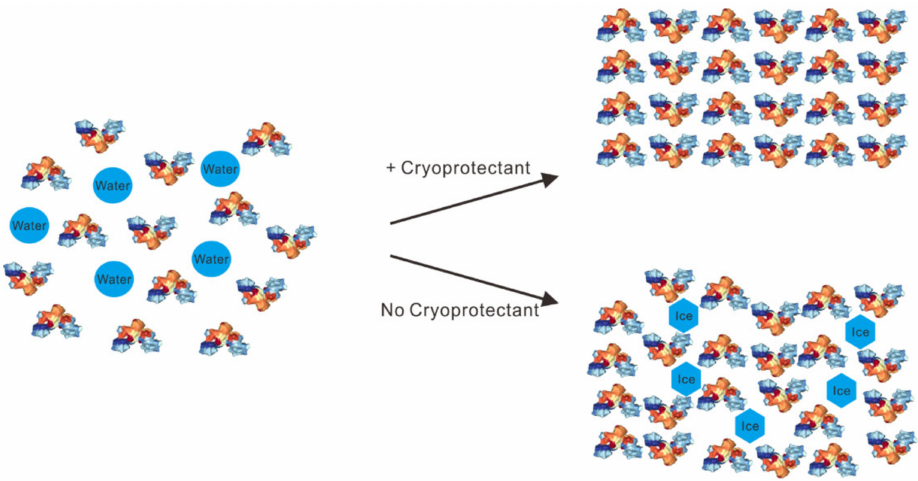
Figure 2. The basic principle of cryoprotection in protein crystals. Directly frozen and/or mis-selected cryoprotectant used protein crystals lead to ice rings on the diffraction caused by cooling environment. The reason is that water molecules contained in protein crystals undergo phase transition from water to hexagonal ice through rapid cooling with liquid nitrogen. This causes the volume of protein crystals to expand, destroys the crystal lattice, and leads to lowering the quality of data. Therefore, proper treatment with cryoprotectants in protein crystals is indispensable for better quality X-ray crystal